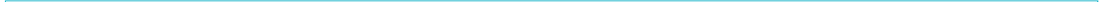
Figure 1: Swimmer plot of treatment duration, response and clinical outcome. The upper 16 patients represent the IMvigor211-like population. The lower eight patients represent those subgroups excluded from IMvigor211. The remaining patient did not have comorbidities or character- istics excluding them from IMvigor211 but had a treatment history atypical of that trial.CNS = central nervous system; ECOG = Eastern Coop- erative Oncology Group; PD-L1 = programmed cell death ligand 1. IC 0/1 = PD-L1 expression on <5% of tumour-infiltrating immune cells; IC